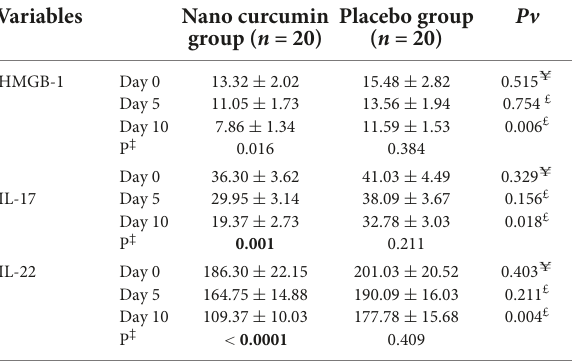
TABLE 6 Effect of nano curcumin supplementation on inflammatory